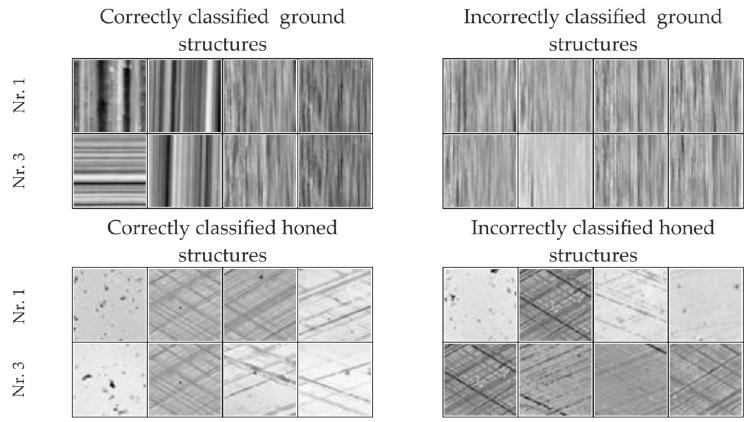
Figure 8. Examples of correctly and incorrectly classified datasets